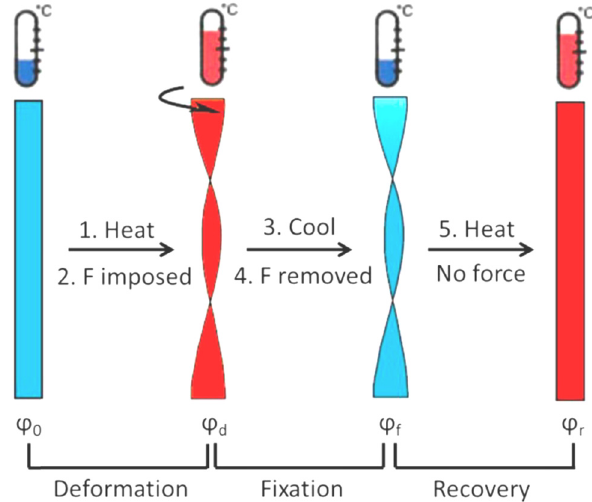
Figure 12: Illustration of shape deformation, fi xation, and recovery cycle of multi - shape memory e ff ect in torsion mode ( 119 ) . Repro - duced with permission from ACS.